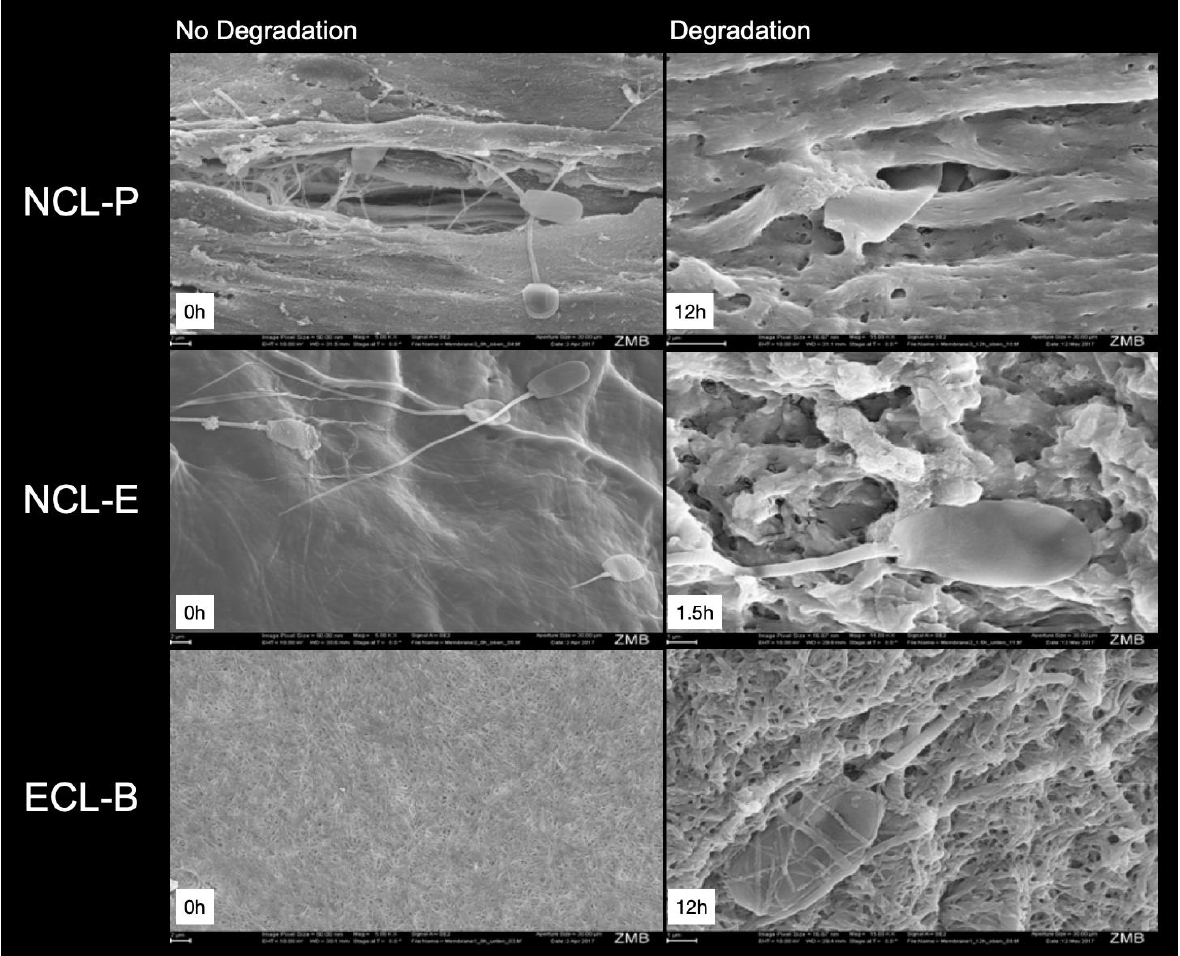
Figure 5. Representative SEM images of the test membranes without degradation (left; magnification, 5000×) and after degradation (right, 15,000×; 1.5 h for NCL-E and 12 h for NCL-P and ECL-E). Please note the sperm cells, which are visible and trying to pass through the collagen fibers and different pores.